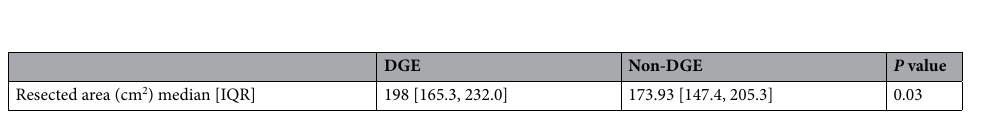
Table 2. Calculation of the resected stomach area using ImageJ. IQR interquartile range, DGE delayed gastric